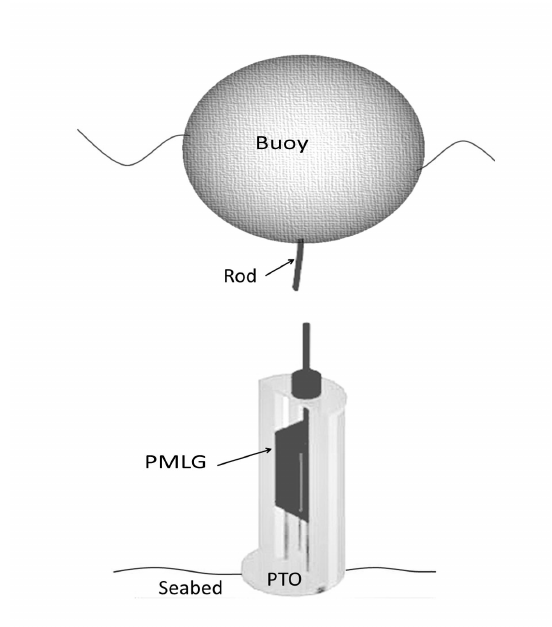
Figure 1. Heaving point absorber